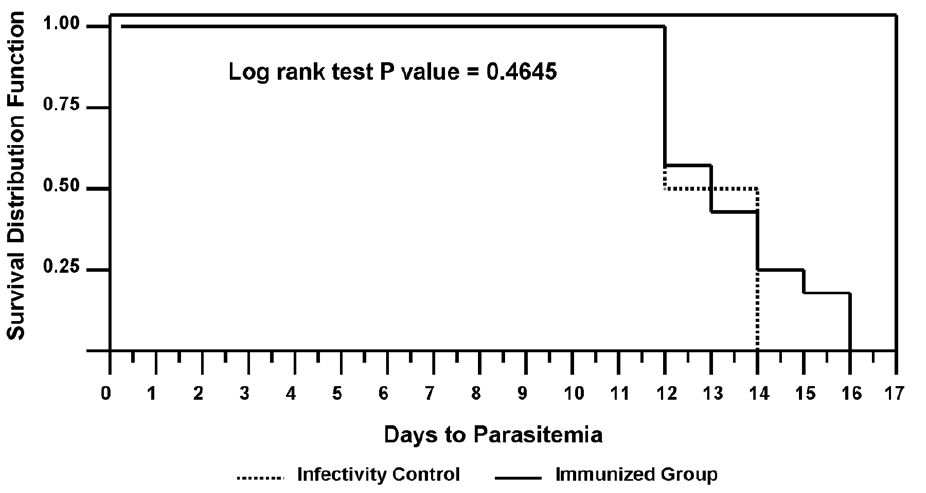
Figure 9. Vaccine Efficacy by Kaplan-Meier Plot. Two immunized volunteers became parasitemic on day 16, more than 2 standard deviations beyond the geometric mean time for the infectivity controls (day 13), indicating a significant delay. When days to patency were compared between the immunized and control groups, there was no difference observed (p=0.46).